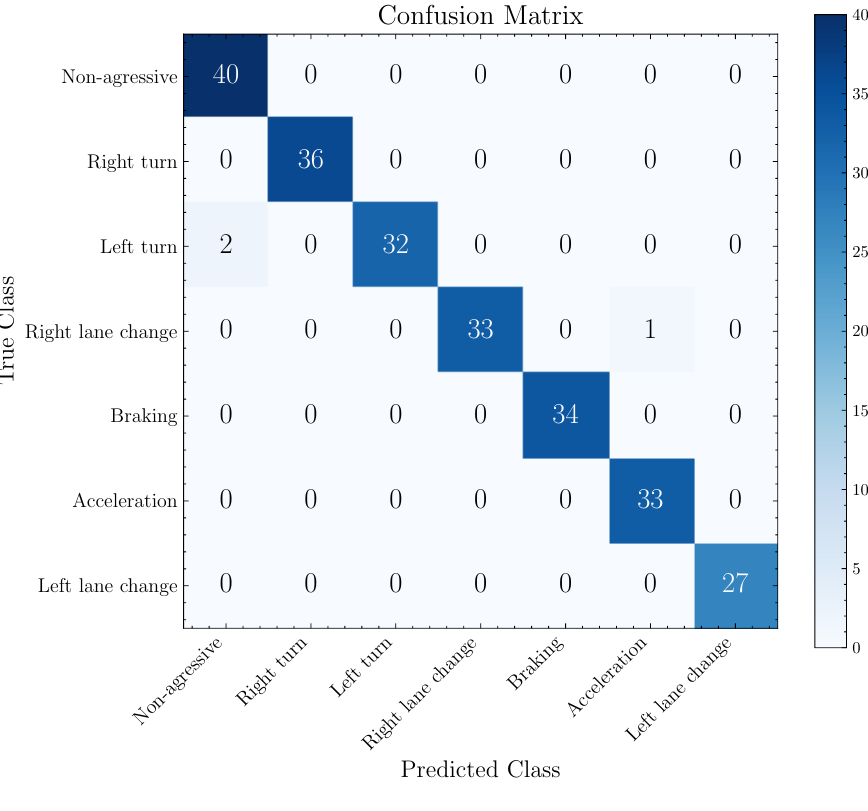
Figure 9. Confusion matrix of the 1D-AlexNet model (best model trained and validated with five-fold cross-validation). Confusion matrix obtained from the evaluation of the entire dataset.